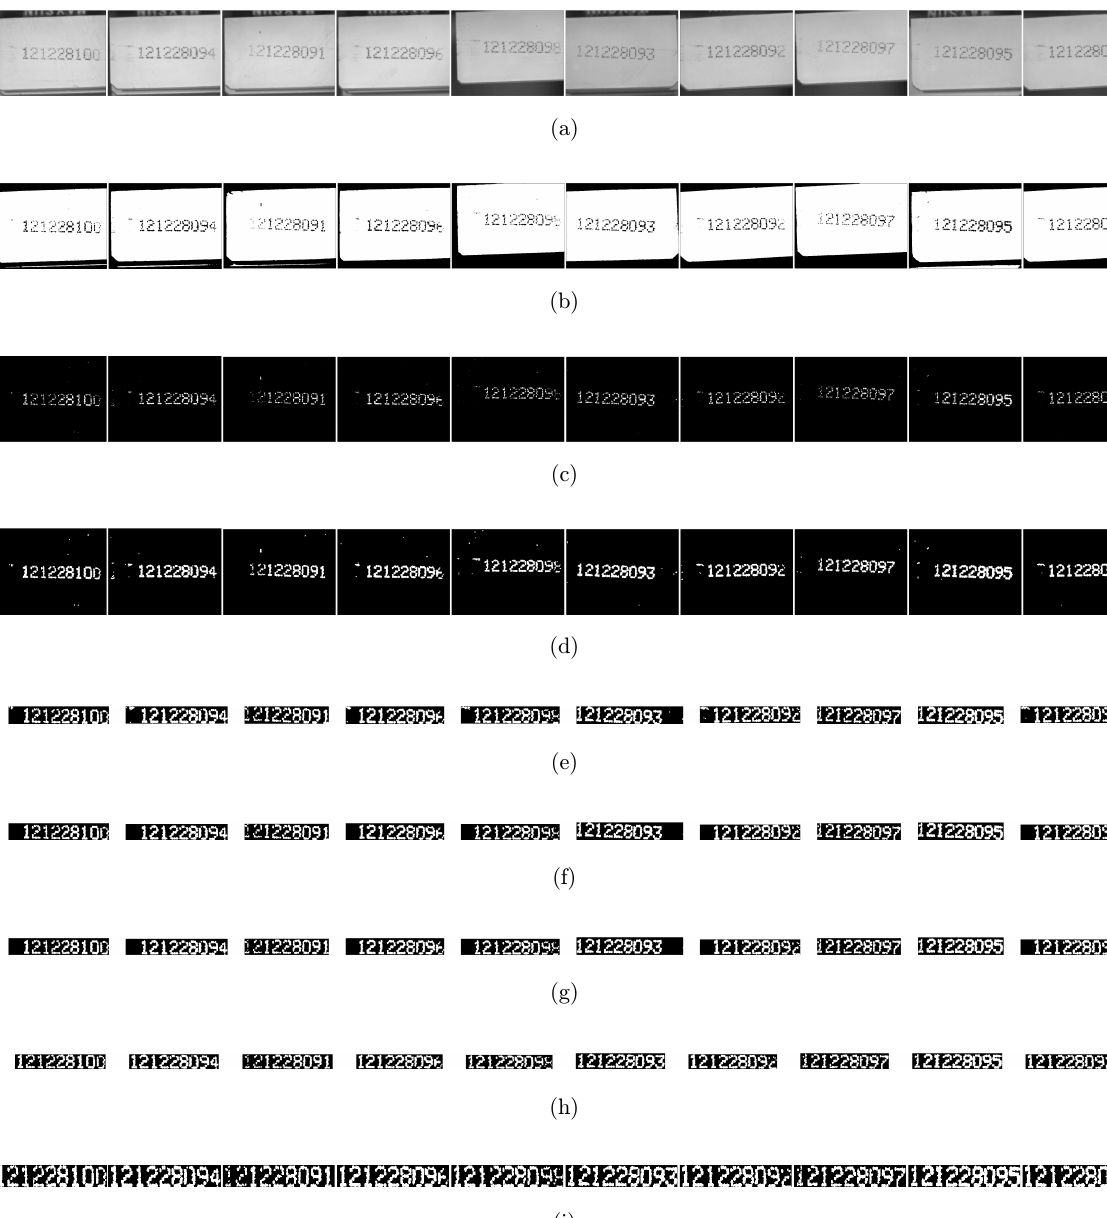
Fig. 15. Blood smear identity authentication procedure and identi¯cation results. (a) Captured DMDC images, (b) binarized DMDC images, (c) highlight DMDC images by ¯ltering out background, (d) further highlight DMDC Images by morphological dilation, (e) cut out DMDC images, (f) images by ¯ltering out noise, (g) images after incline correction, (h) DMDC by precise location, (i) normalized DMDC and (j) the identi¯cation